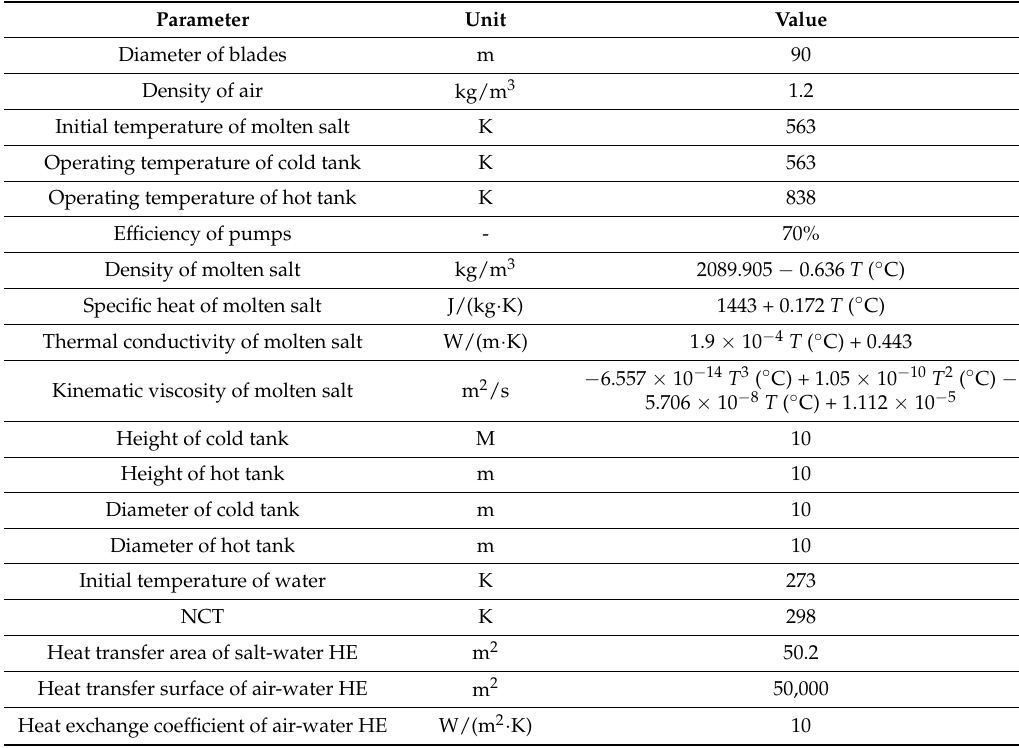
Table 1. Design parameters of the integrated WTES system. NCT: normalized comfort temperature; HE: heat